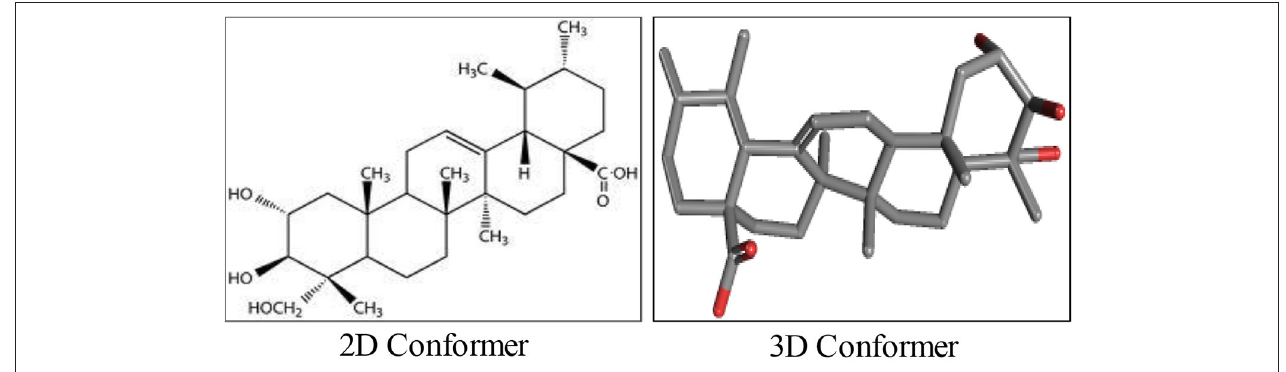
FIGURE 1 | The chemical structure of asiatic acid.